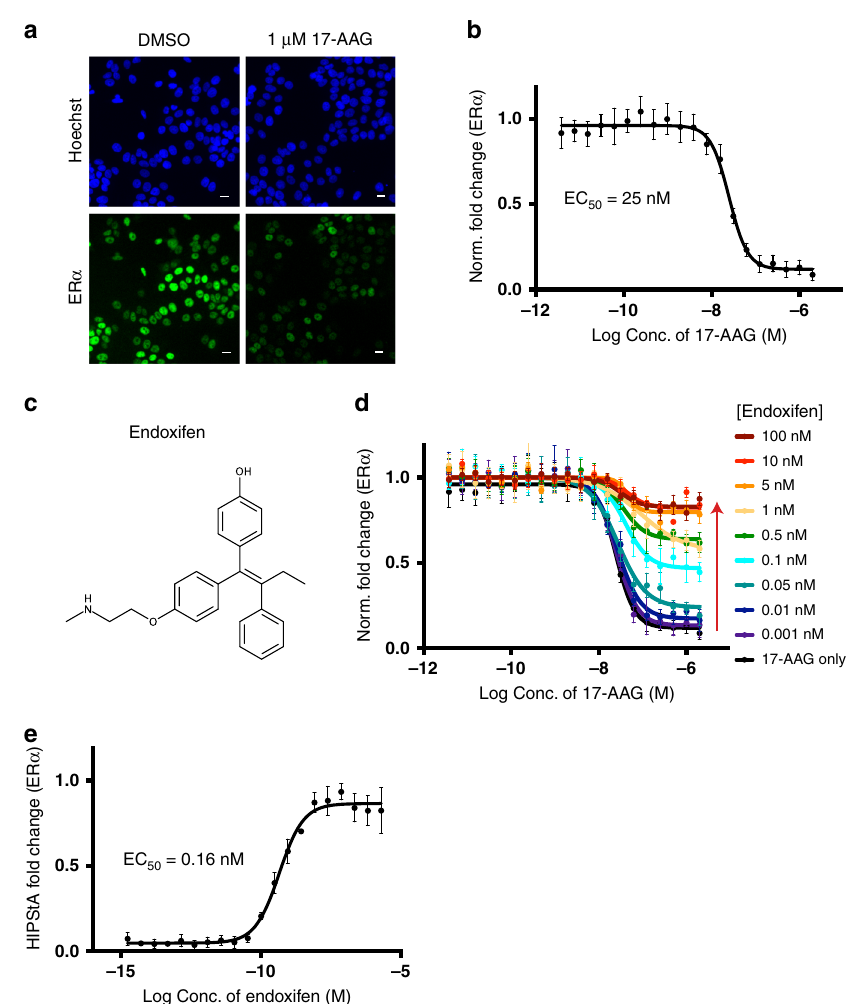
Fig. 1 Quantitative fl uorescence imaging measuring the effect of 17-AAG on ER α . a Immuno fl uorescence images of ER α protein in MCF-7 cells treated with DMSO or 17-AAG (1 µ M) for 4 h. The upper panels show Hoechst 33342 staining of the DNA (blue) indicating the nuclear region, while the lower panels show the ER α immuno fl uorescence stain. Scale bar − 20 μ m. b The change in mean ER α protein per cell (MCF-7) was calculated for a range of concentrations of 17-AAG and expressed relative to the ER α level in DMSO treated samples and the no primary antibody control sample. c Endoxifen chemical structure. d Measurement of the relative ER α protein levels in MCF-7 cells pre-treated with a range of concentrations of Endoxifen then treated with a titration of 17-AAG (x-axis) for 4 h. e Measurement of the relative ER α protein levels in MCF-7 cells pre-treated with a titration of Endoxifen then treated with 2 µ M 17-AAG. ER α protein levels are expressed as the fraction of ER α present in the co-treatment condition relative to the corresponding concentration of inhibitor only (HIPStA Fold Change). The relative EC 50 value was calculated using a four parameter quadratic curve fi t in PRISM. Error bars represent standard error of mean ( n = 3). Source data are provided as a Source Data fi